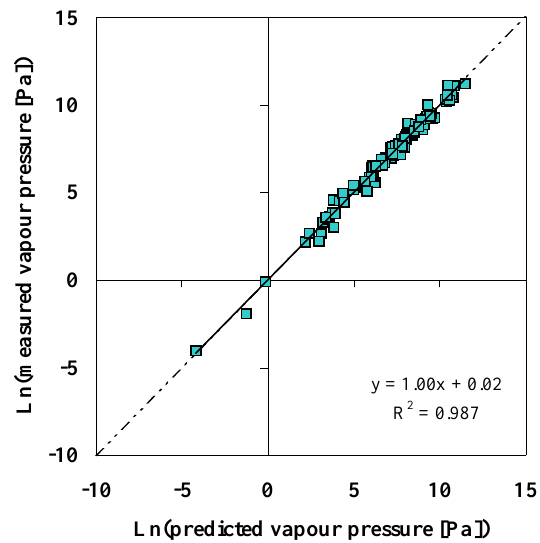
Figure 7. Test of P_PREDICT. Model for oxygen containing compounds. Prediction of ln p from the compounds’ chemical (UNIFAC) structure. The line, which fits the data best, is of the general form: y = (1.00 ± 0.02) x + (0.02 ± 0.07). n = 93. Average bias of prediction is: –2.0 10 -6 , SEP is 0.32, and RMSEP is 0.32 log